Question: Reading the figure, is the described quantity rising or falling?
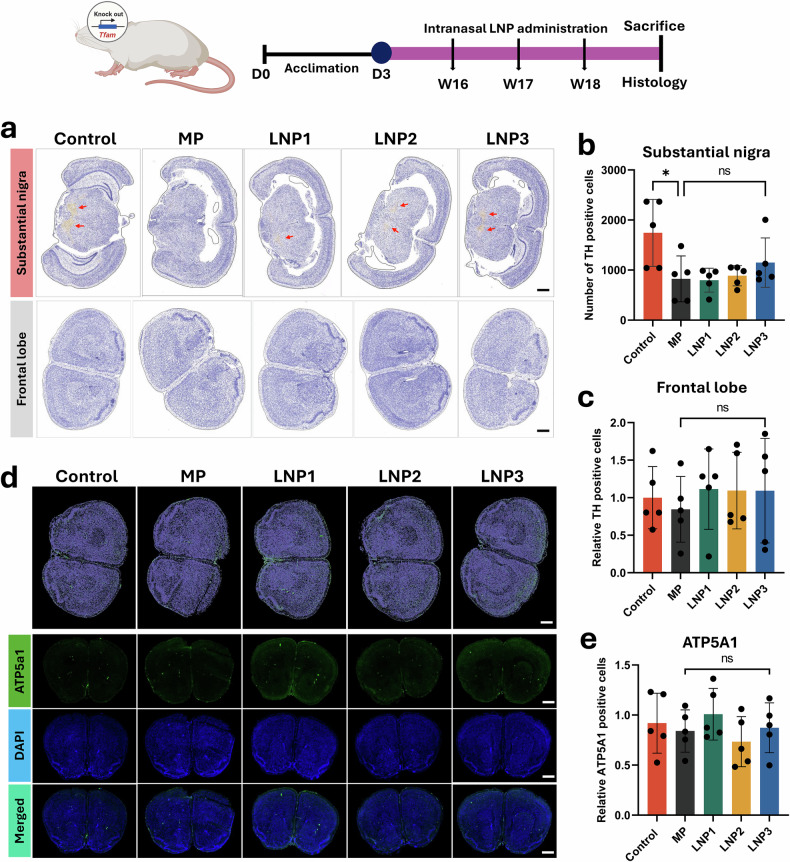
Answer: decreasing